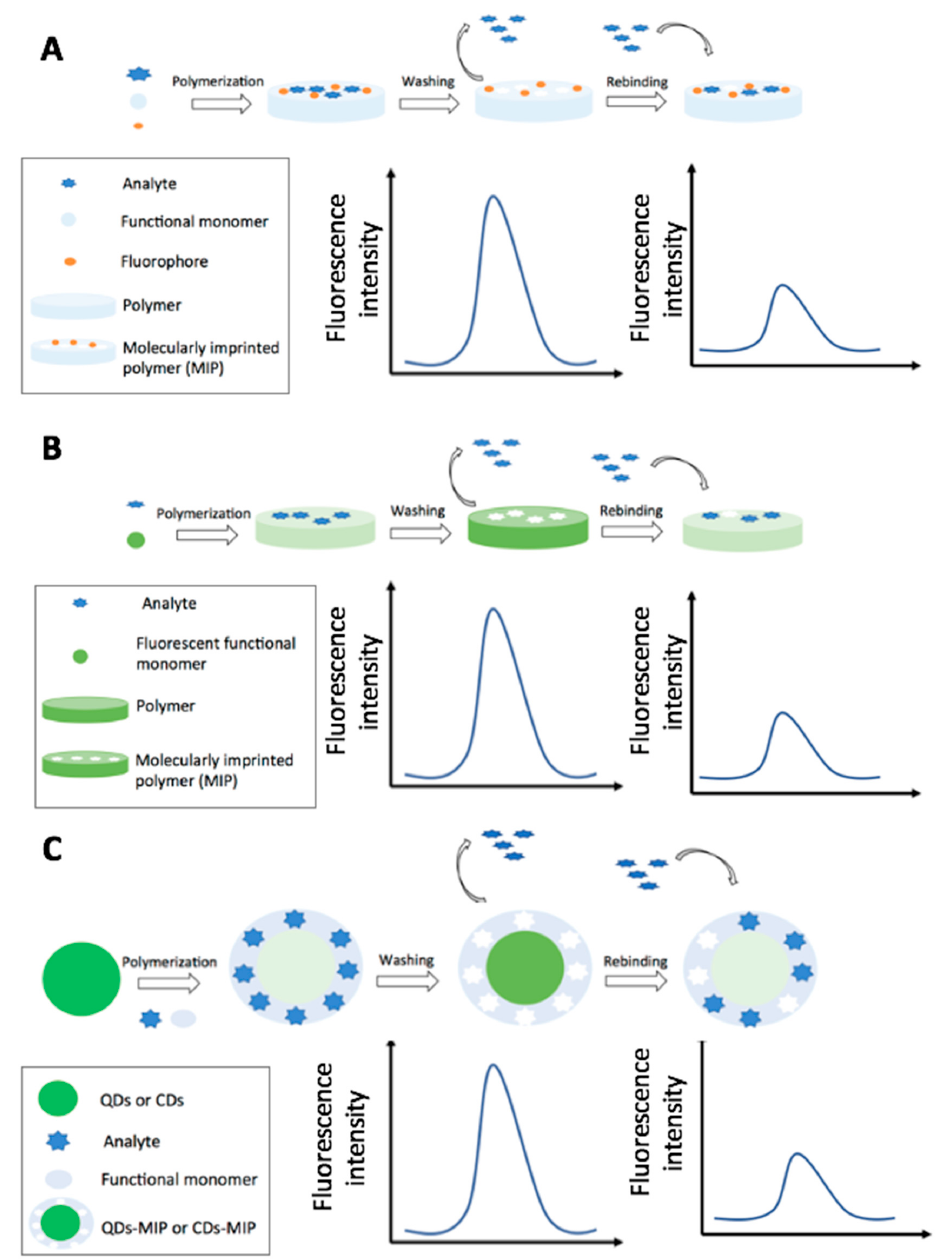
Figure 7. Schematic representation of optical MIPs production with the main fluorescence-based detection strategies by the use of a fluorophore ( A ); by the use of a fluorescent functional monomer ( B ) and exploiting the fluorescence quenching of QDs or CDs ( C ).